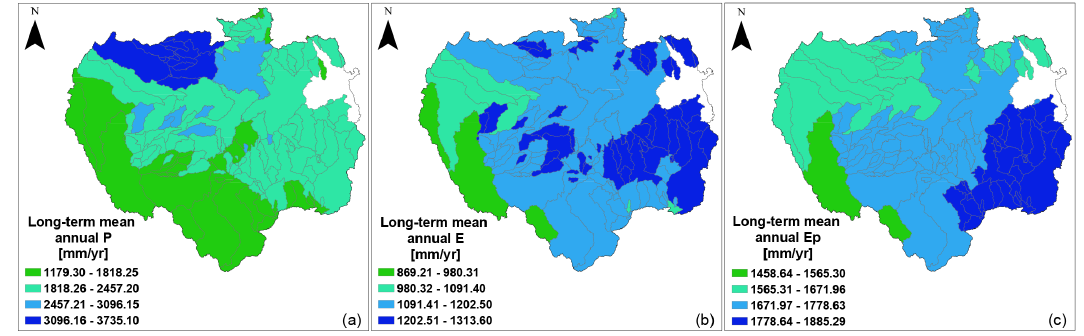
Figure 10. Spatial distribution of the long-term mean annual P , E and E p across the sub-catchments of the Amazon River